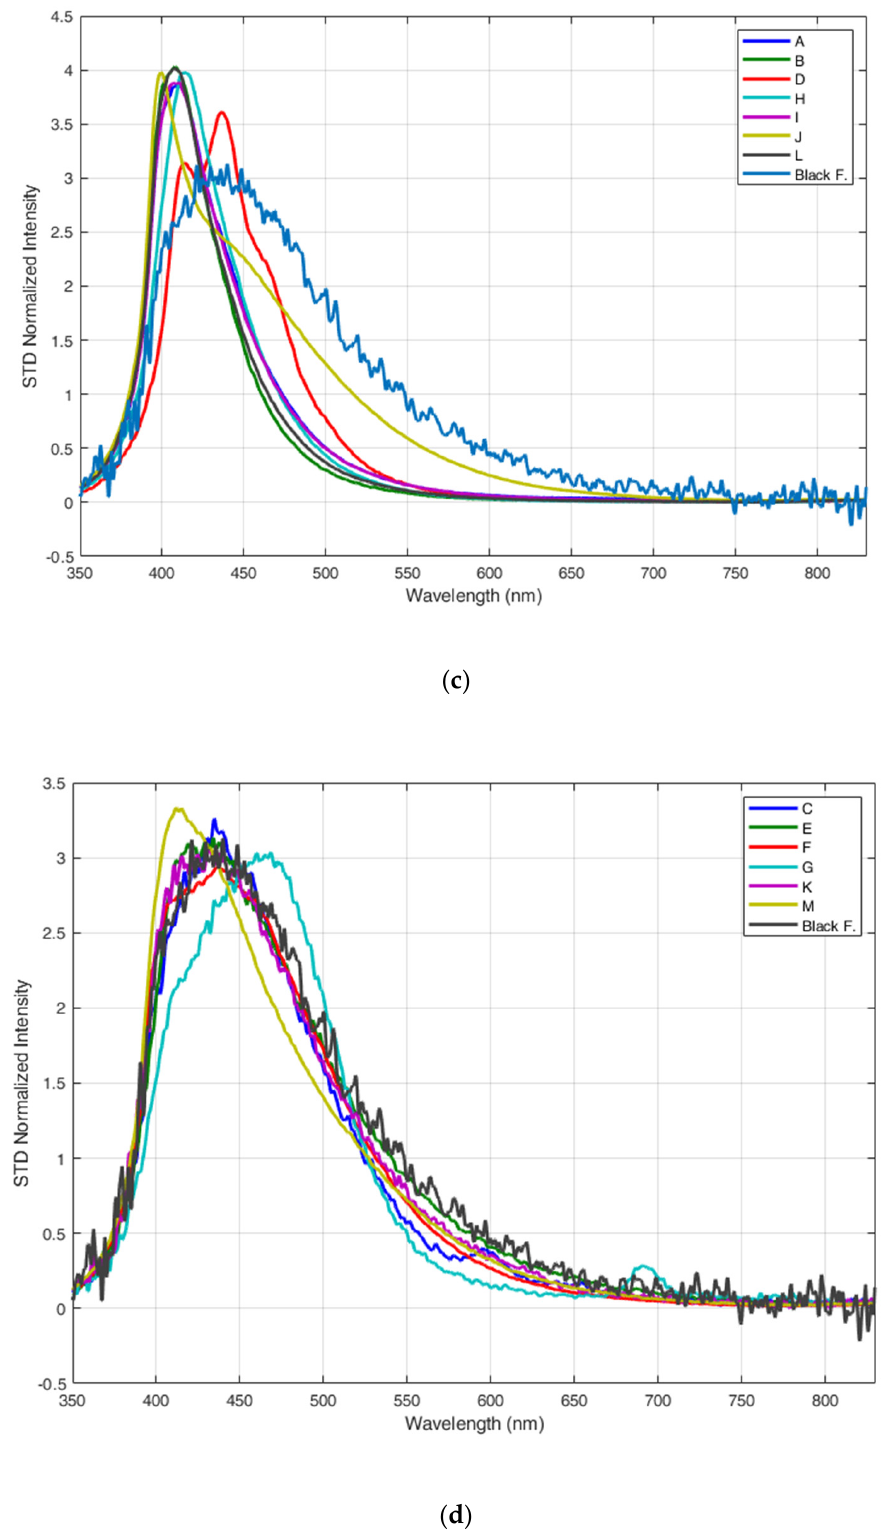
Figure 3. Fluorescence LIDAR spectra of the dry plastic samples: ( a ) fluorescence spectra of samples A, B, D, H, I, J, L; ( b ) fluorescence spectra of samples C, E, F, G, K, M; ( c ) fluorescence spectra of samples A, B, D, H, I, J, L, normalized to the standard deviation (STD), and ( d ) fluorescence spectra of samples C, E, F, G, K, M, normalized to the standard deviation (STD).